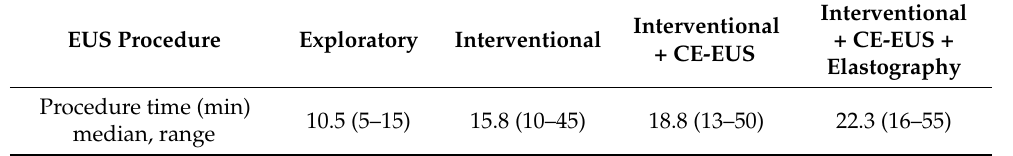
Table 3. EUS procedural time.